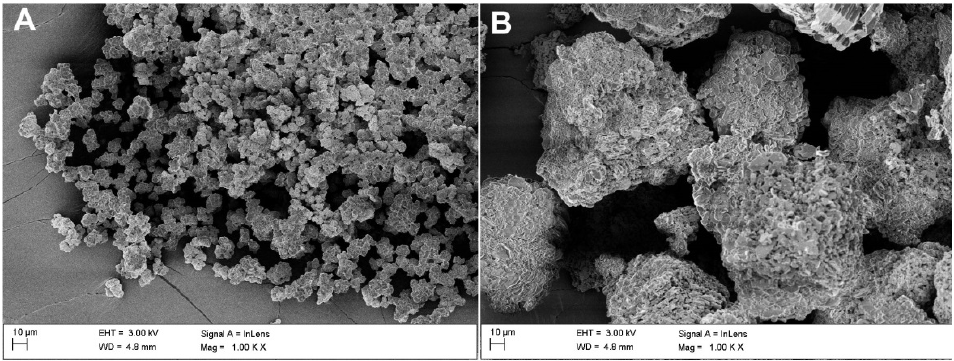
Figure 4. Starting powders: ( A ) raw ZrO 2 and ( B ) raw Al 2 O 3 .